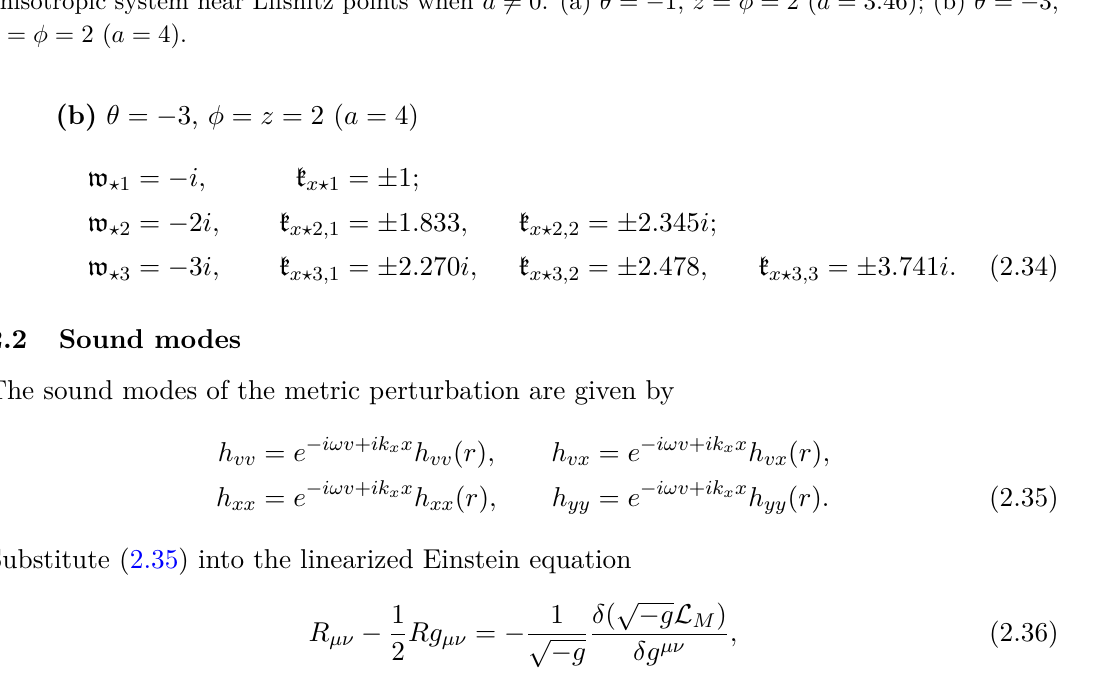
along the x -direction in the x